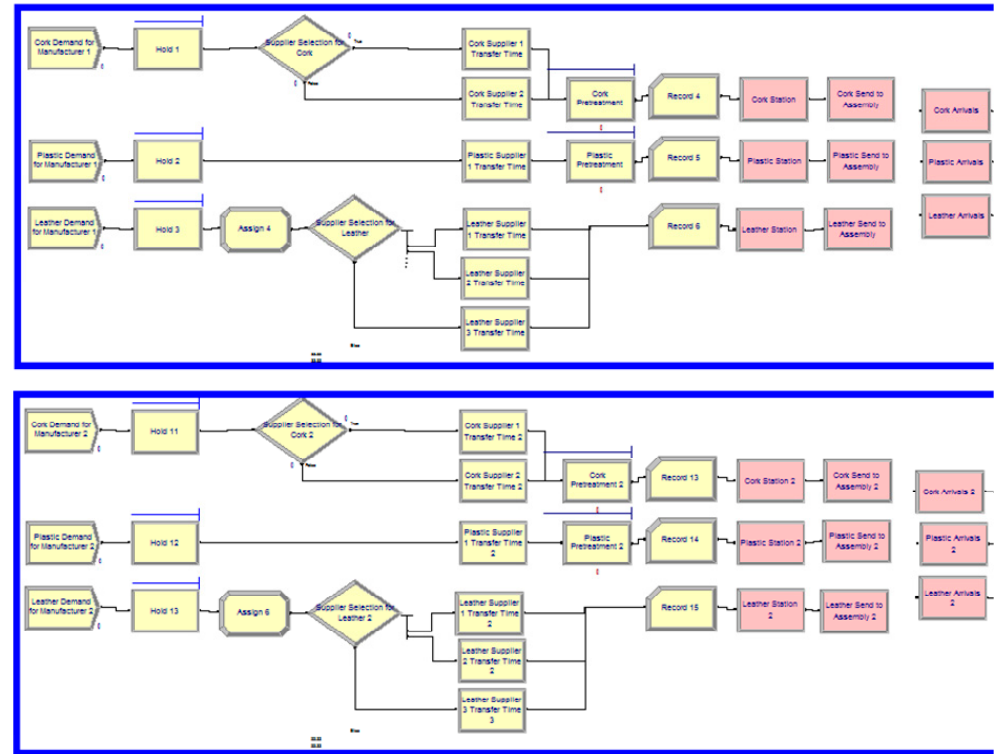
Figure 7. Customer arrivals to the orthopedist.